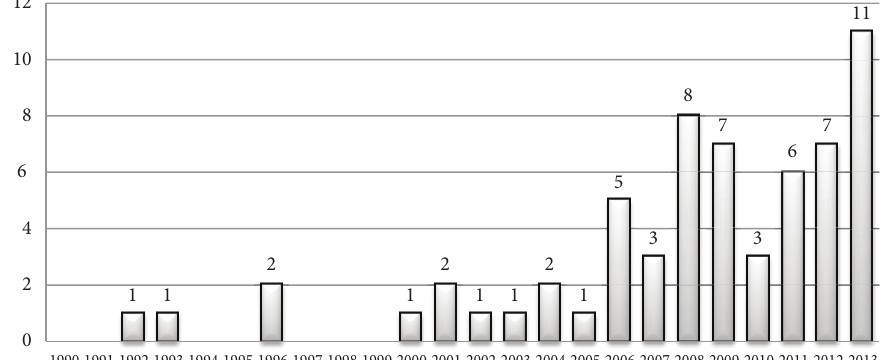
Fig. 2. Number of publications on topic: review papers on MCDM methods (based on ISI Web of Science database)